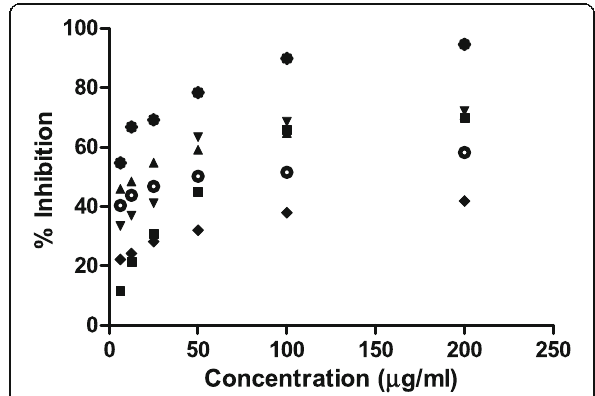
Fig. 2 α -Glucosidase Inhibitory Activity at Different Concentration of Methanol Extract and its Fractions. The IC 50 values of Methanol Extract and its Hexane, EoAC, BuOH, R. aqueous Fractions are 0.06139 mg/ml, 0.04457 mg/ml, 0.05369 mg/ml, 0.3747 mg/ml, 0.0635 mg/ml and 0.03854 mg/ml, Respectively. Legends: